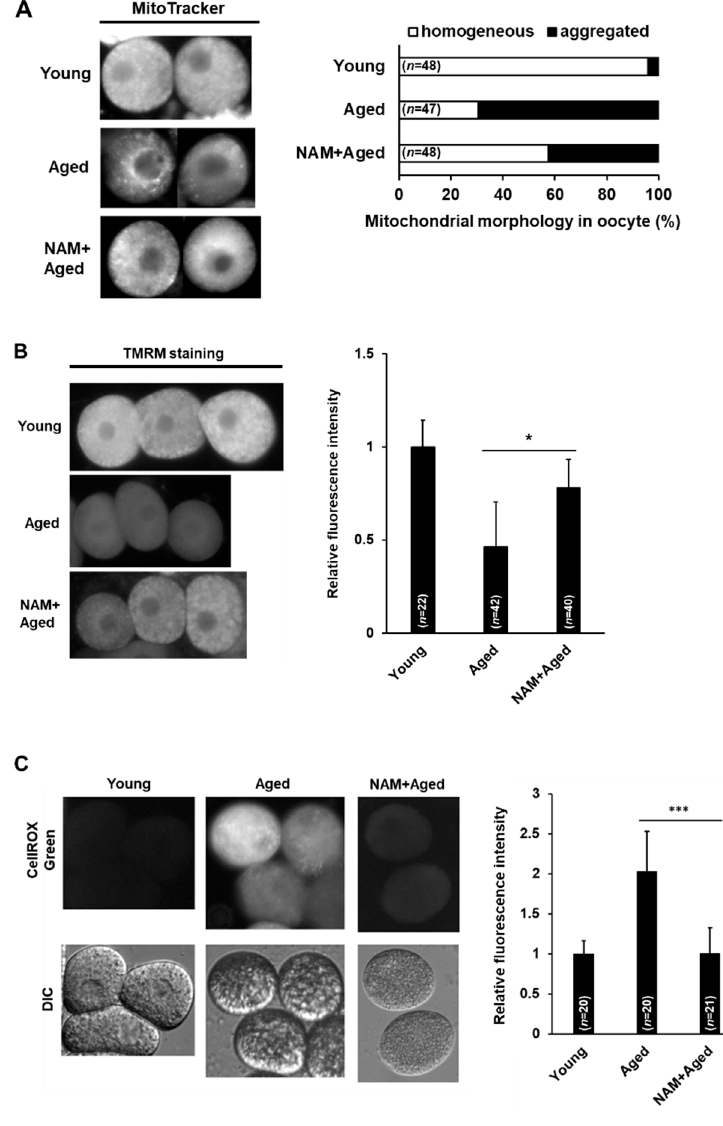
Figure 3. Mitochondrial dysfunction in aged oocytes is improved by nicotinamide (NAM) supplementation in Caenorhabditis elegans : ( A ) Comparison of mitochondrial activity and morphology in young, aged, and NAM+aged oocytes using MitoTracker staining. The graph indicates the percentage of oocytes with mitochondria classified as homogeneous or aggregated; ( B ) Comparison of mitochondrial membrane potential (MMP) in young, aged, and NAM+aged oocytes using tetramethylrhodamine methyl ester (TMRM) staining. The fluorescence of TMRM was quantified for each condition using ImageJ. The graph shows the relative levels of MMP. Error bars represent standard deviation (SD). *, p < 0.05 (one-way ANOVA with Tukey’s post hoc test); ( C ) Comparison of mitochondrial reactive oxygen species (ROS) levels in young, aged, and NAM+aged oocytes using CellROX Green staining. The graph shows the relative levels of mitochondrial ROS by ImageJ analysis. Error bars represent SD. ***, p < 0.001 (one-way ANOVA with Tukey’s post hoc test).